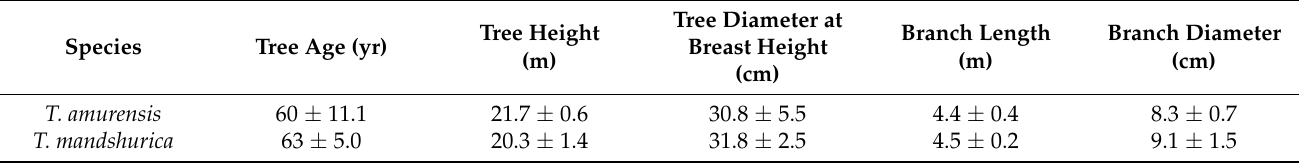
Species Tree Age (yr)